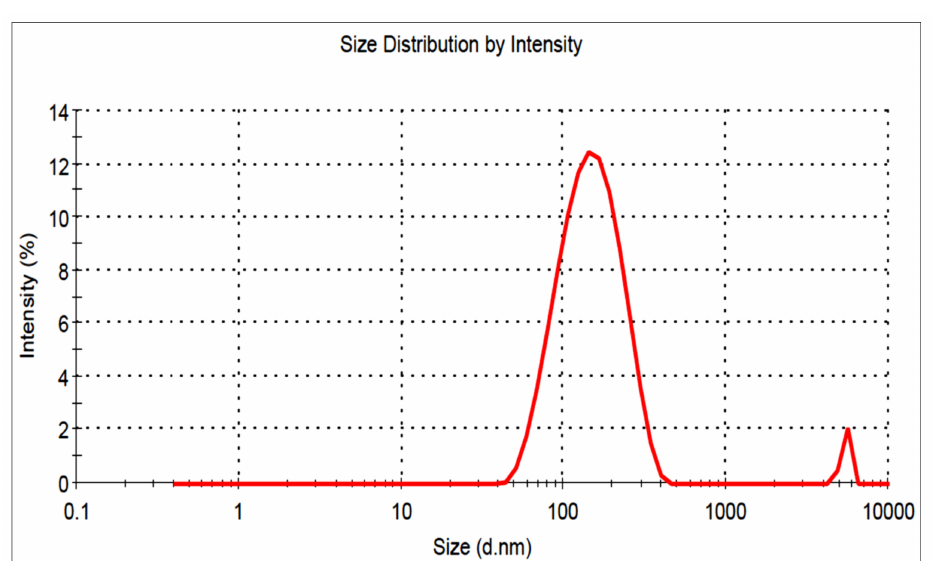
Table 4. Different combinations of carbopol and chitosan were used to select the